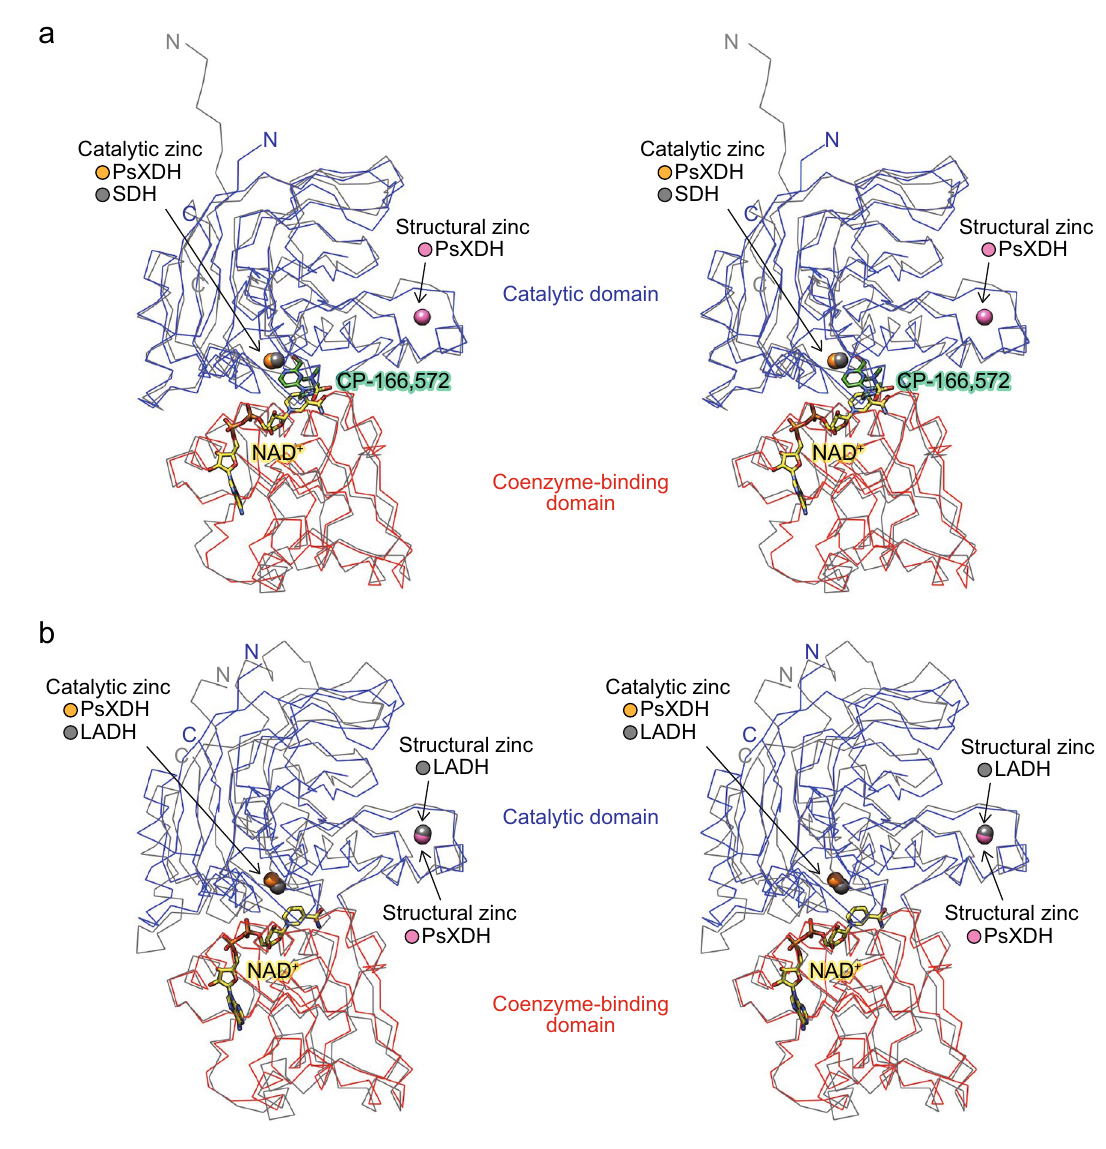
Figure 4. Stereo view of the superimposed Cα traces of the coenzyme binding domains of PsXDH C4 and SDH from human in complex with the competitive inhibitor (CP-16657213) and NAD + (1PL6; gray) ( a ), or LADH from Neurospora crassa in complex with NAD + (3M6I; gray) ( b